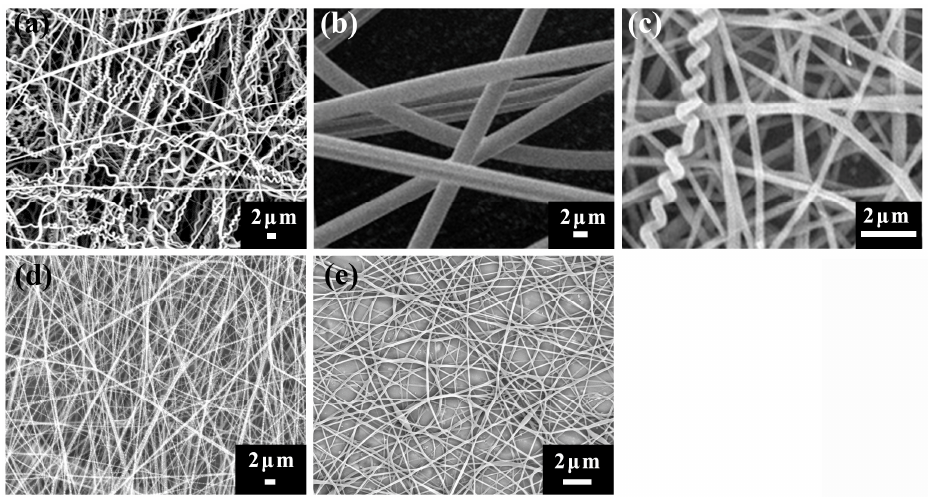
Figure 1. SEM images of three component systems: ( a ) Nomex/TPU fibers from 12 wt % Nomex with 1.8 wt % LiCl and 18 wt % TPU, ( b ) PS/TPU fibers from 20 wt % PS and 18 wt % TPU, ( c ) PAN/TPU fibers from 12 wt % PAN and 18 wt % TPU, ( d ) 12 wt % Nomex with 1.8 wt % LiCl and ( e ) 18 wt %